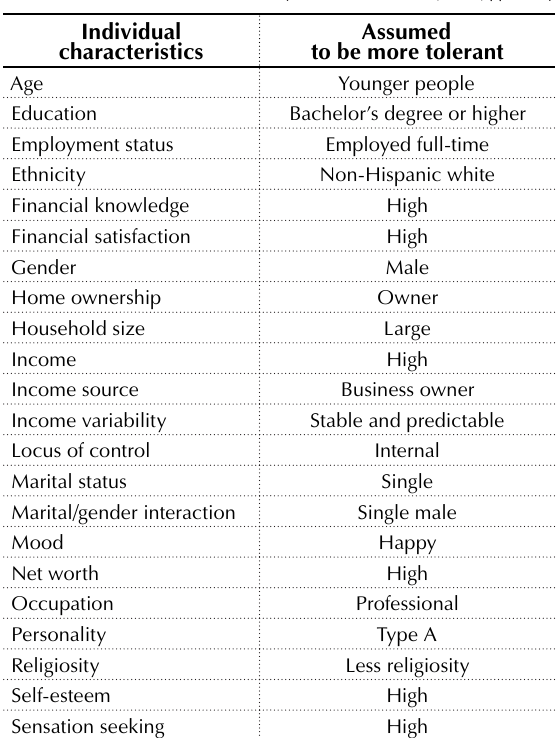
Table 1. Factors associated with financial risk